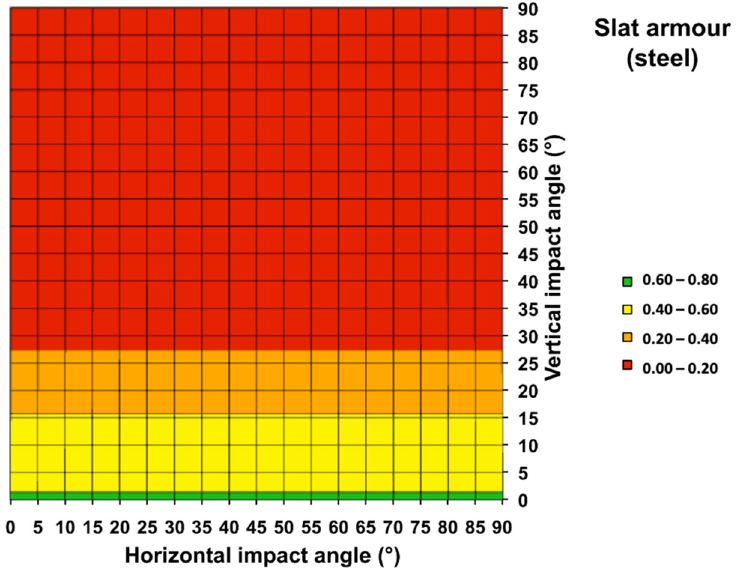
Figure 17. Efficiency of a steel slat cage armour solution as a function of the horizontal and vertical impact angle.